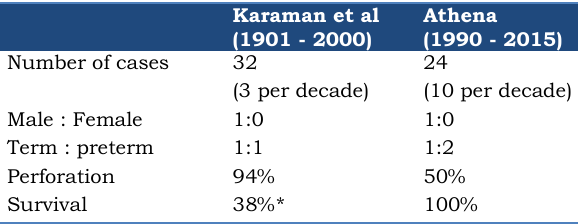
Table 3: Comparison of hernial appendicitis over time Karaman et al (1901 -